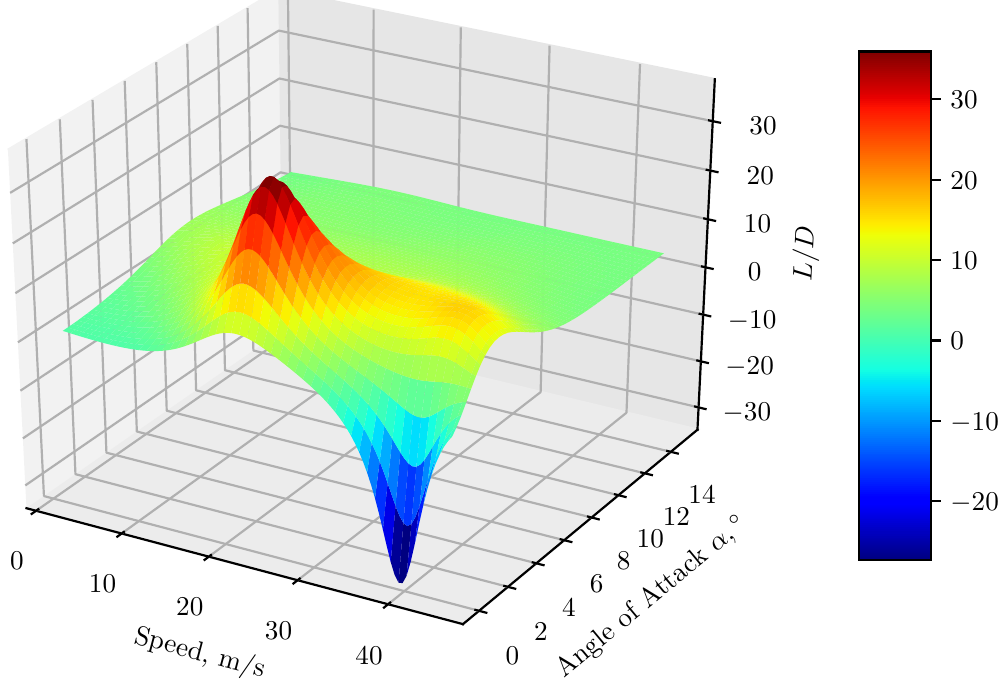
Figure 12. Response surface for the Waid-Lindberg supercavitating hydrofoil’s ( L / D ) hf